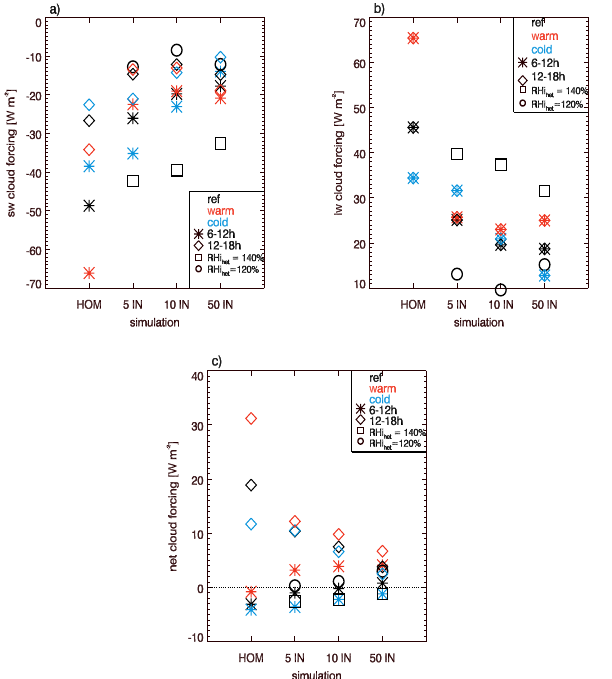
Figure 9. Averaged shortwave cloud forcing (a) , longwave cloud forcing (b) and net cloud forcing (c) for the simulations HOM, 5 IN, 10 IN and 50 IN. Black, red and blue asterisks (diamonds) show the results for the reference, warm and cold temperature profiles for 06:00–12:00LT (asterisks) and 12:00–18:00LT (diamonds) for the simulation where the IN freeze at Rhi het = 130%. Additionally, the results where RHi het is increased to 140% (black square) or decreased to 120% (black circles) are shown for the reference tem- perature profile and the time period from 06:00 to 12:00LT. For the calculation of the mean, only values where τ > 0 . 03 are considered.